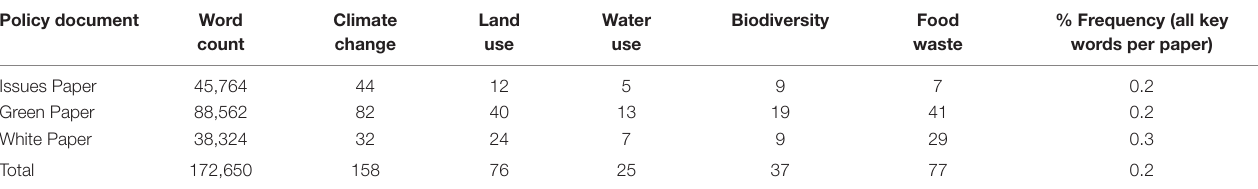
TaBle 3 | content analysis of key words in nFP policy papers.